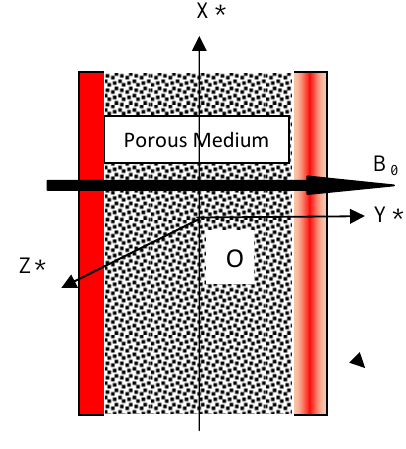
Fig. 1a. Hot vertical channel. Fig. 1b. Spanwisecosinusoidal plate temperature.